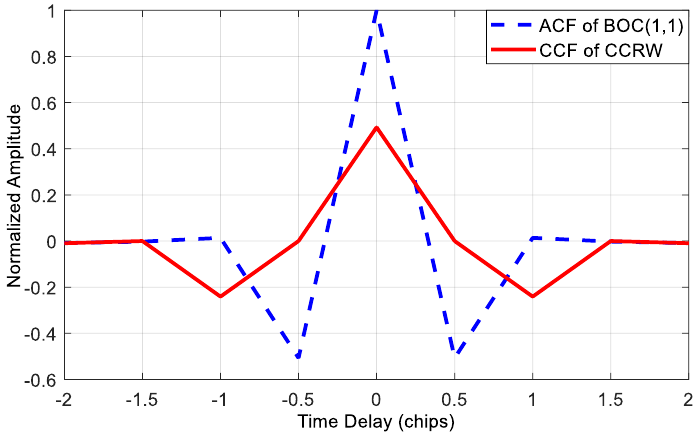
Figure 9. The CCF between BOC(1,1) signal and local CCRW signal.